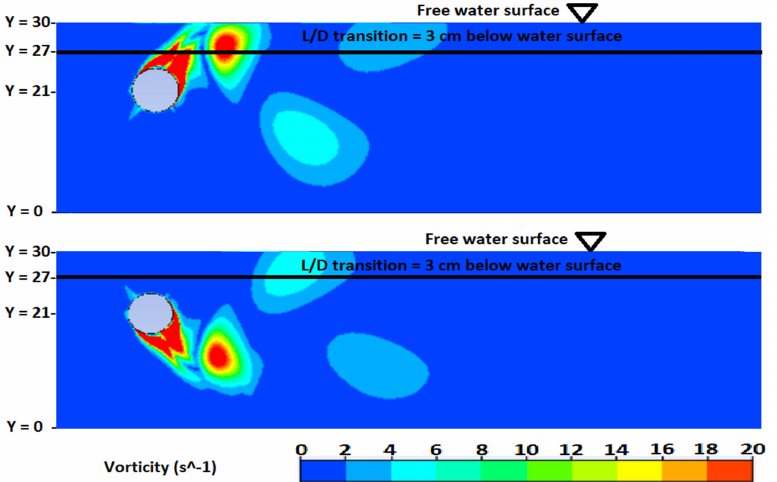
Figure 10. Vorticity field created by cylinder oscillation when cylinder is at neutral (middle) position. Above contour is captured when cylinder is moving down, below contour is captured when cylinder is moving